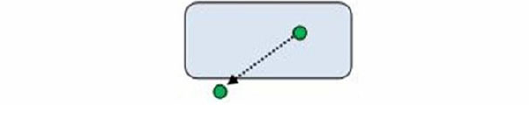
Figure 4. Kenneth’s first trip diagram.